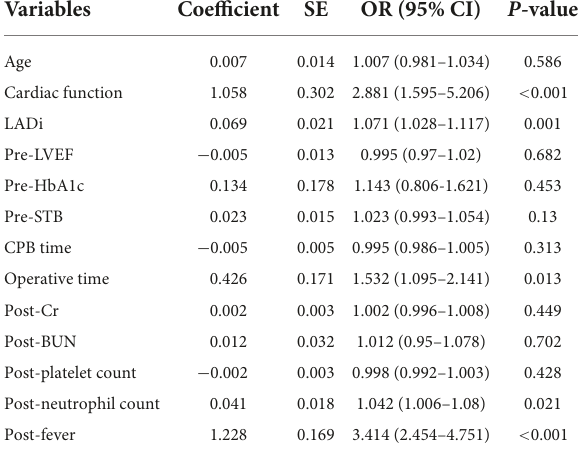
TABLE 3 Multivariate logistic regression analysis of screened variables.